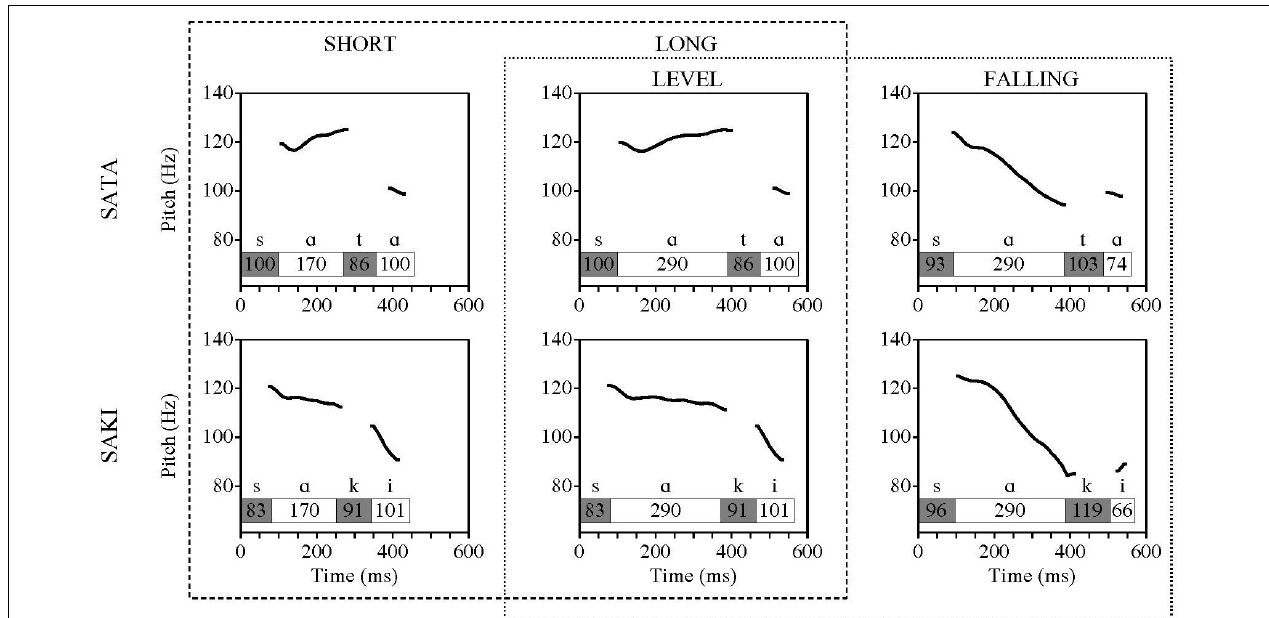
FIGURE 1 | Overview of stimuli used (duration of syllables and pitch contour). The specifications of the first vowel are marked on a row above the columns. The length of the first vowel was either 170 or 290 ms, and had either a level or falling pitch contour. The length of other consonants and vowels was fixed for every stimuli – first consonant (S) 100 ms, second consonant (T/K) 86 ms and second vowel (A/I) 101 ms. Dashed line marks comparisons with duration change, dotted line marks comparisons with changes in pitch contour.